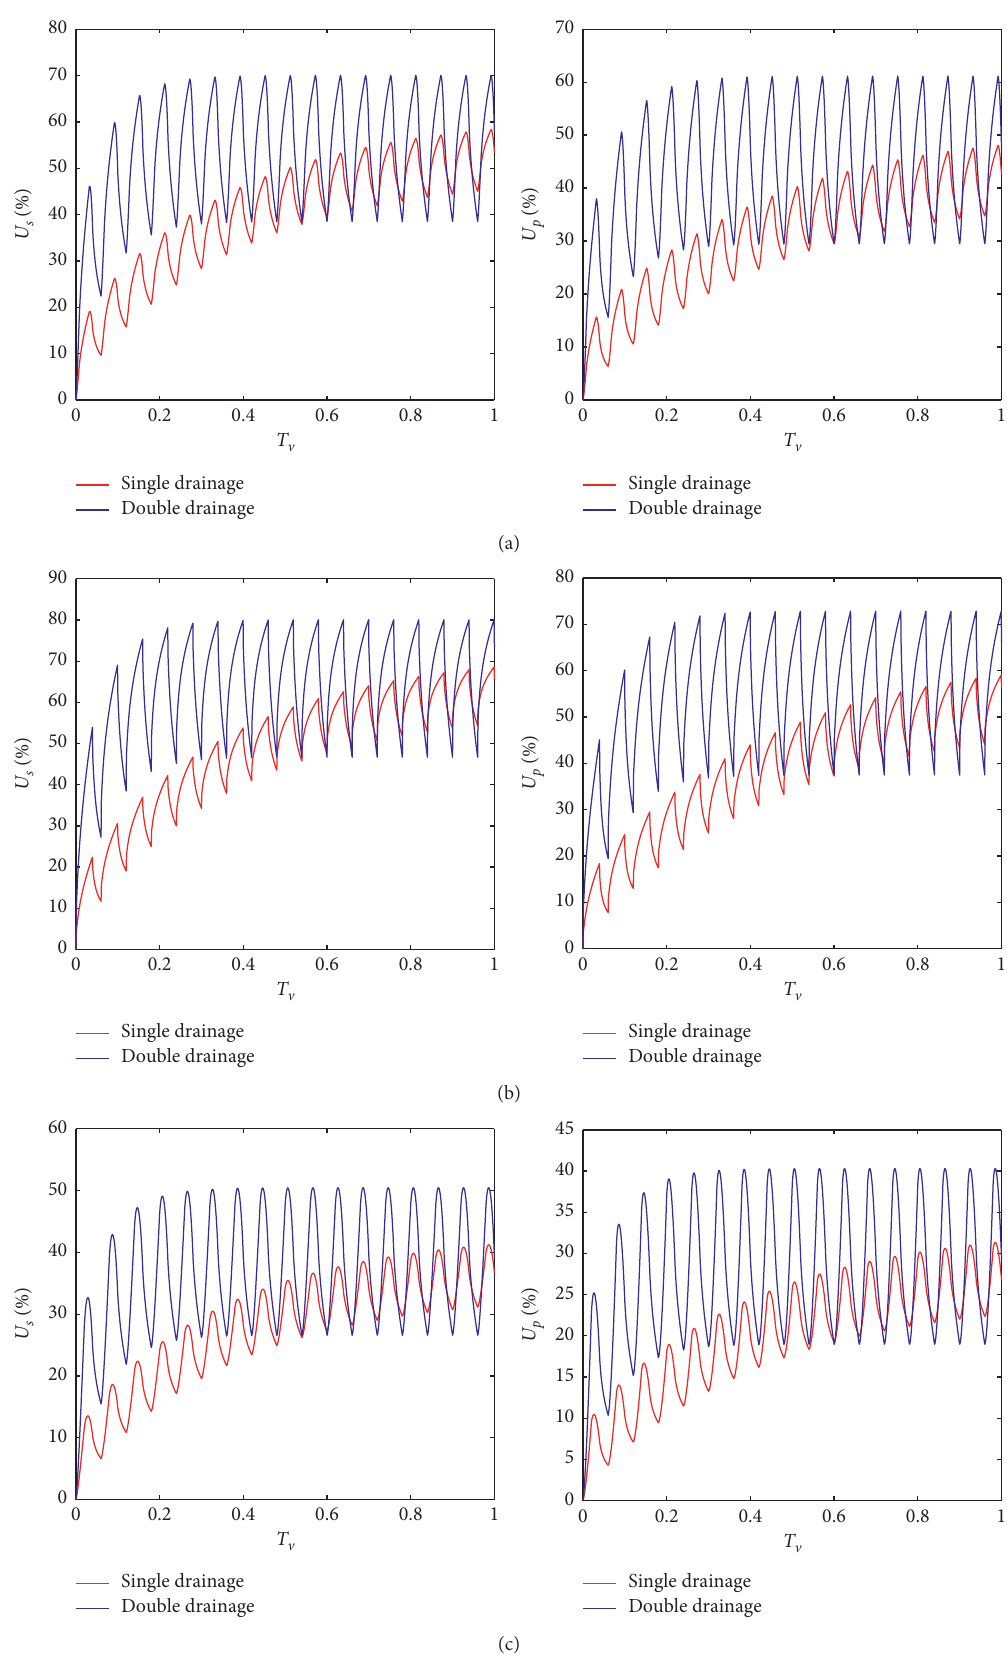
Figure 12: The variations of average degrees of consolidation U